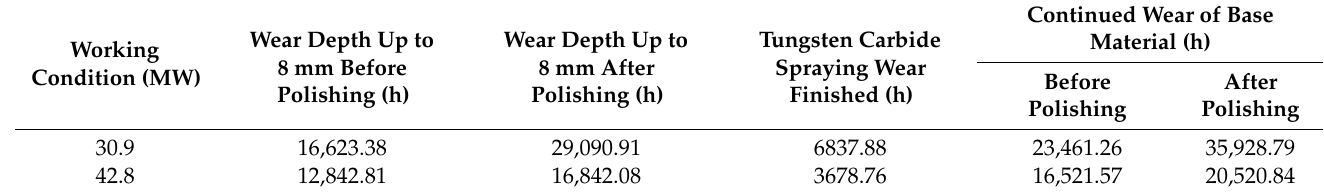
Table 7. Estimated life of the guide